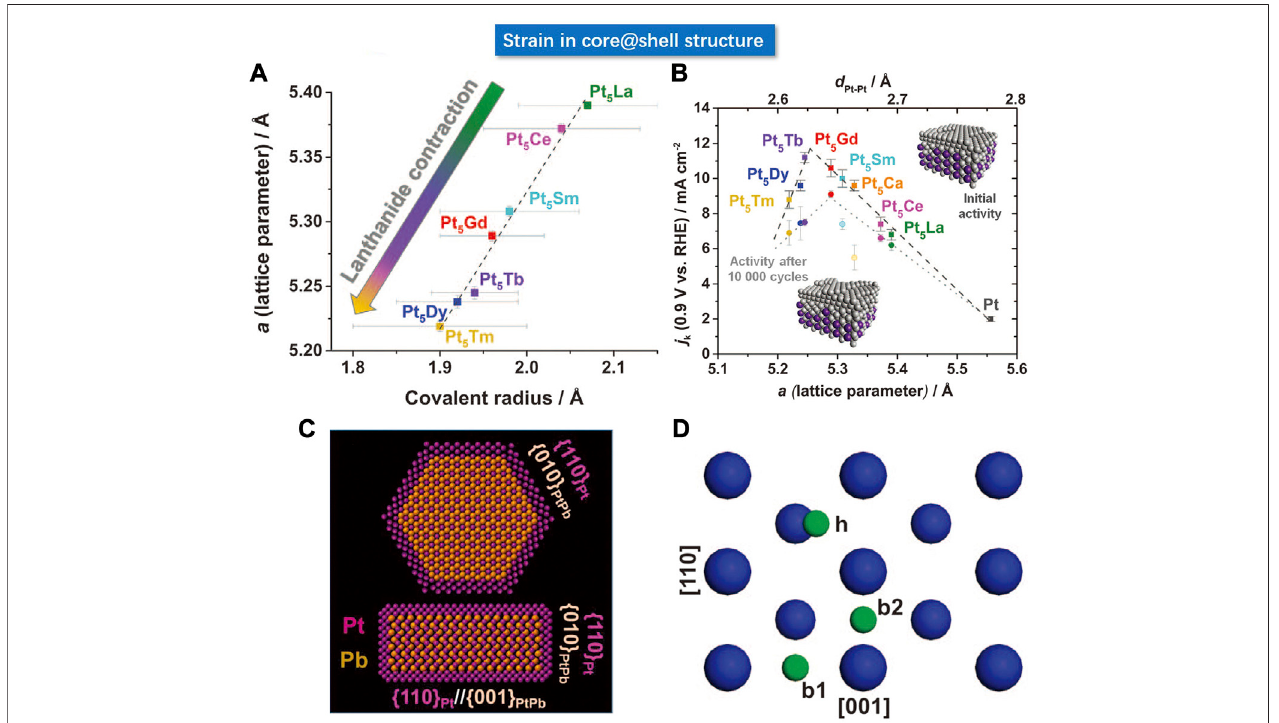
FIGURE 11 | (A) Relationship between lattice parameters and covalent radius of lanthanide (La, Ce, Sm, Gd, Tb, Dy, Tm, etc.), wherein the scattered points are approximately linear. (B) Volcanic relationship between lattice parametersand ORRkinetic current. (C) Atomic model ofPtPb@Pt hexagonalnanoplates. (D) Schematic of (100) crystallographic facet, blue balls represent Pt atoms. (A – D) Reproduced with permission (Bu et al., 2016b; Escudero-Escribano et al., 2016). Copyright 2016, American Association for the Advancement of Science.